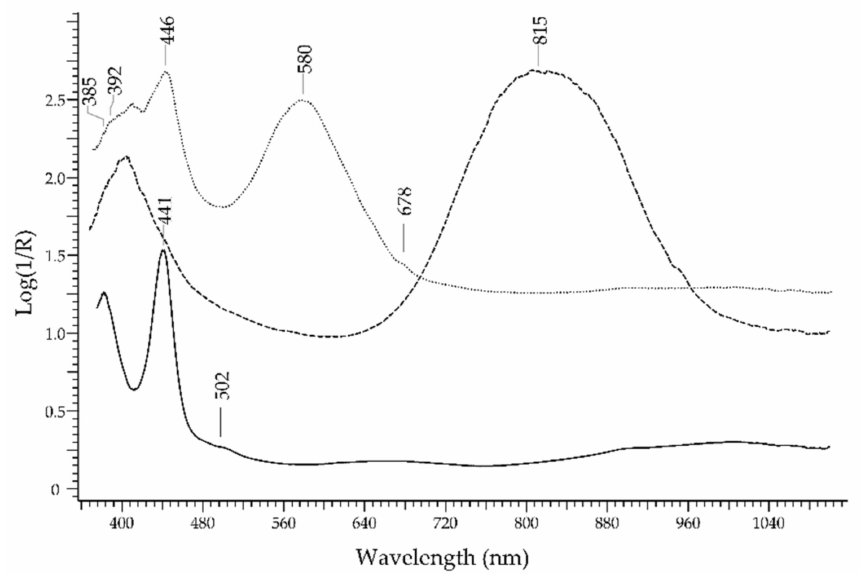
Figure 7. FORS spectrum in Log(1/R) coordinates of alexandrite (dotted line), a green heliodor (dashed line) and a yellow chrysoberyl (solid line).